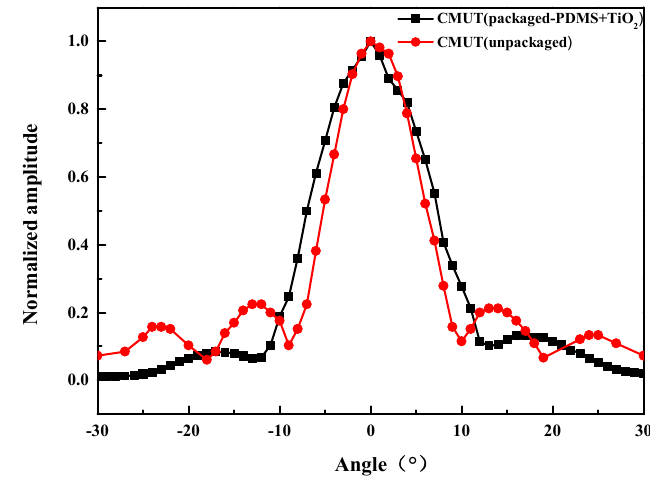
Figure 16. Transmitting directivity of the CMUT with and without coating.